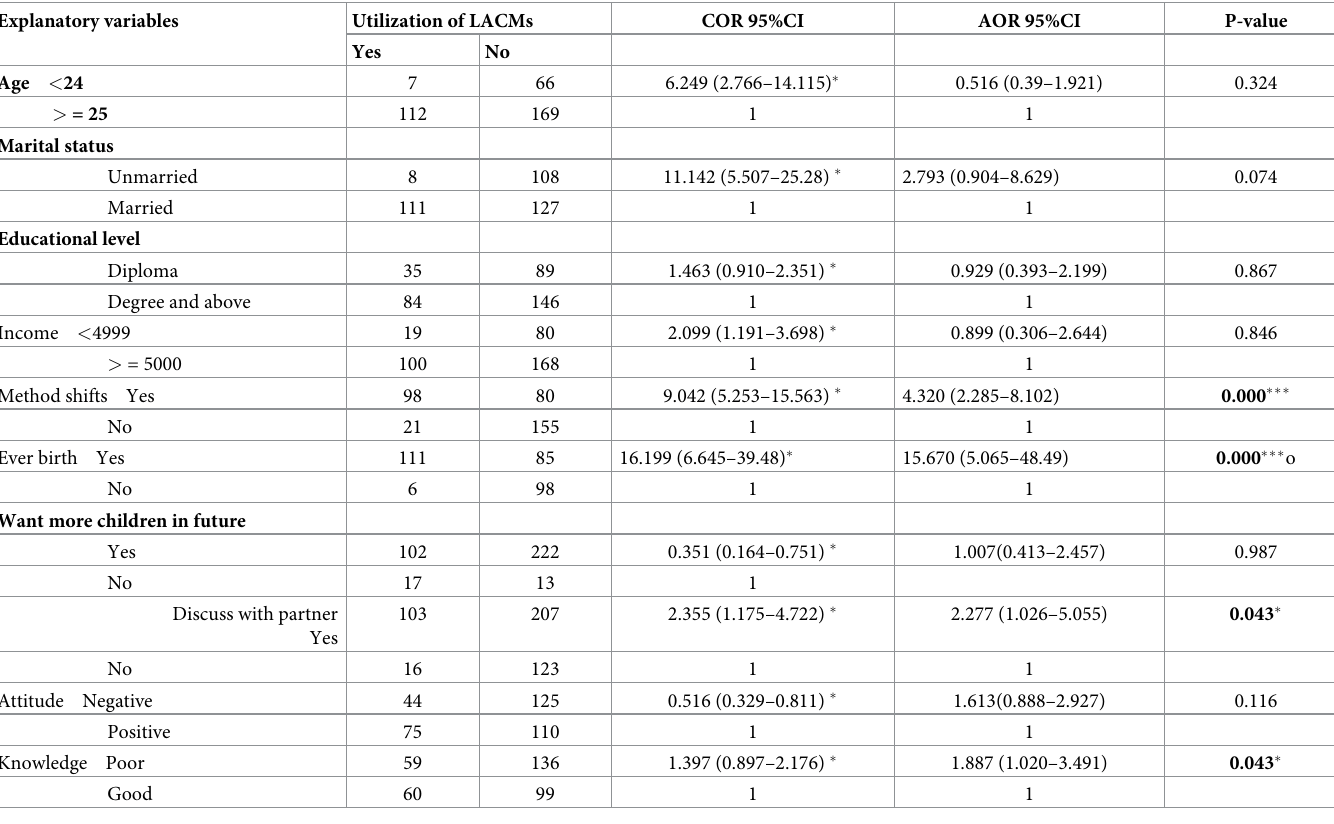
Table 7. Factors associated with the utilization of long-acting contraceptive methods among reproductive aged female healthcare workers in south wollo zone, Ethi- opia, in 2021, n =